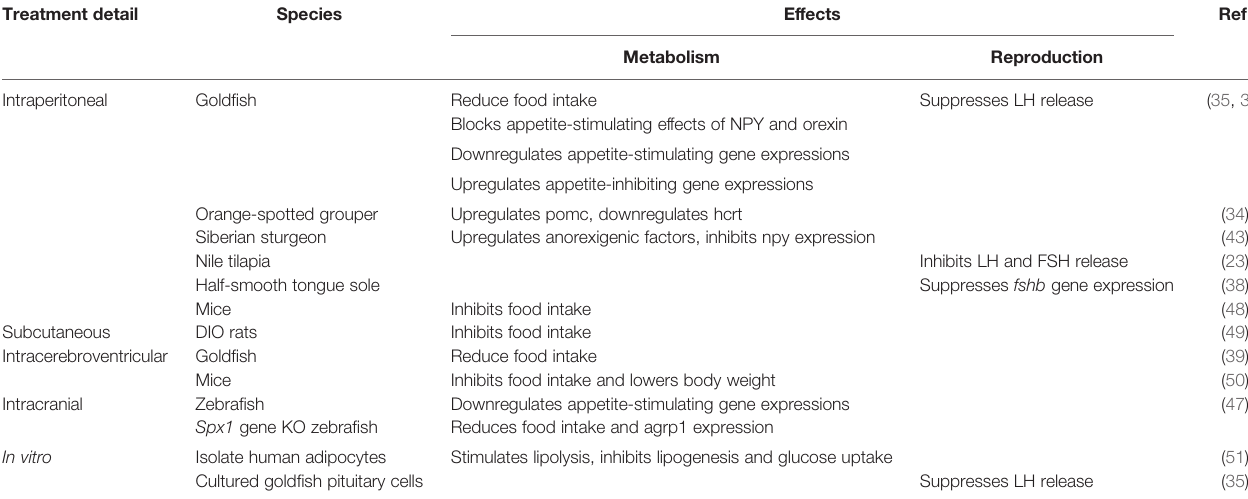
TABLE 5 | Details of SPX treatment in various animal models and mediums, with the effects in metabolism and reproduction. Treatment